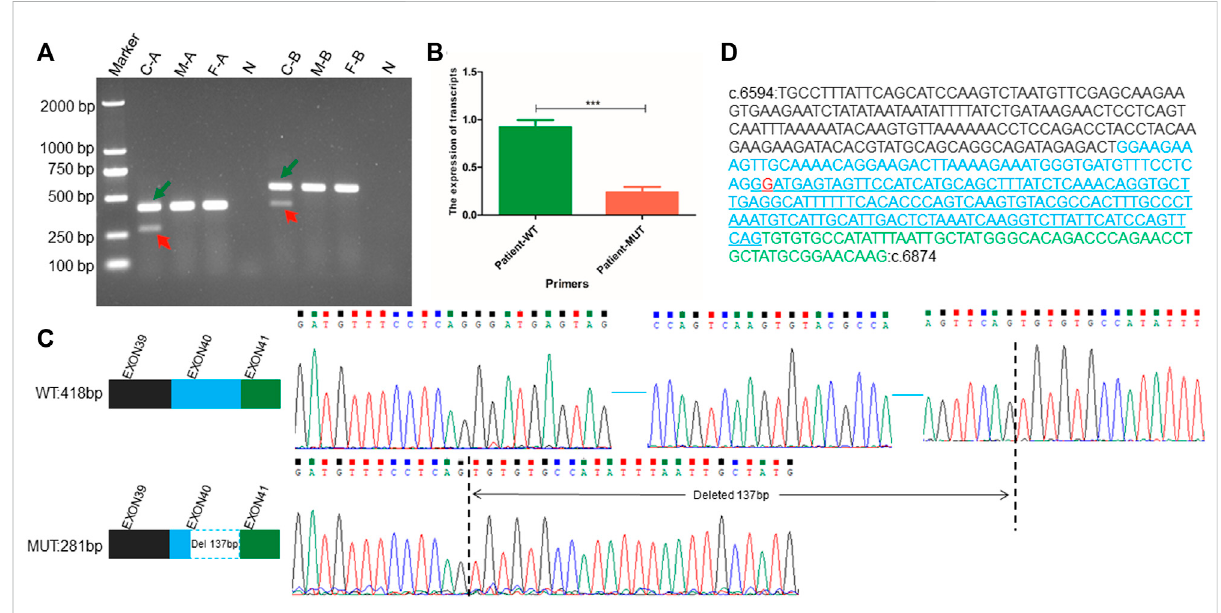
FIGURE 2 RNAtranscriptanalysisperformedusingRT-PCR,qPCR, andSangersequencing. (A) Agarosegelelectrophoresis showingRT-PCRresultsusing primer pairs A and B targeting the exonic regions fl anking the position of the NIBPL de novo synonymous variant (c.6819G > T (p.Gly2273 = ) in exon 40.Greenarrowspointtonormaltranscripts(wild-typetranscript),andredarrowspointtoalteredshorttranscripts(varianttranscript). “ C ” represents the patient, “ F ” represents the father of the patient, “ M ” represents the mother of the patient, “ N ” represents the negative control derived using thegDNAofthepatientasanampli fi cationtemplate, “ A ” representsthepairA,and “ B ” representsthepairBampli fi cationprimer (B) Thetranscription levelofwild-typefull-lengthtranscripttoalteredmutantshorttranscriptin NIPBL .WTrepresentstheuniquesequenceofwild-typetranscript,which can only speci fi cally amplify the wild-type transcript; MUT represents the unique sequence of the altered short mutant transcript, which can only speci fi cally amplify the abnormal transcript attributed to the c.6819G > T variant. (C) Patterns and sequences of wild-type transcript and altered short transcriptattributedtovariation.Theupperleftrepresentsthesplicingpatternofwild-typecDNA,andtheupperrightrepresentstheexactsequence ofwild-typecDNAsplicing.Thebluehorizontallinerepresentstheomittedwild-typesequence.Thelowerleftrepresentsthealteredsplicingpattern of cDNA attributed to variation (The blue dashed box indicates 137 bp deletion at the 3 ′ end of exon 40 in NIPBL ), and the lower right represents the exact sequence obtained after altered splicing of cDNA attributed to variation. The vertical black dotted line indicates the sequence position of abnormal splicing deletion (D) The exact sequence of cDNA ampli fi ed by primer Pair A. The blue underlined sequence indicates the deletion of a 137 bp sequence. The black font represents the partial base sequence of exon 40, the blue font represents the base sequence of exon 40, and the green font represents the partial base sequence of exon 41. The red base G represents the mutation